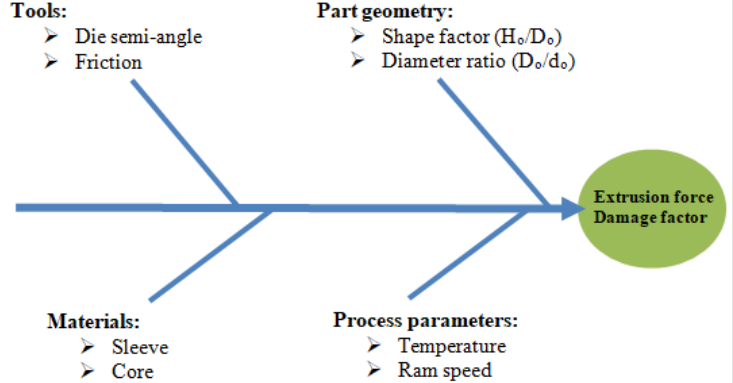
Figure 6. Comparison chart between Johnson and FEM extrusion force for a multi-material billet.